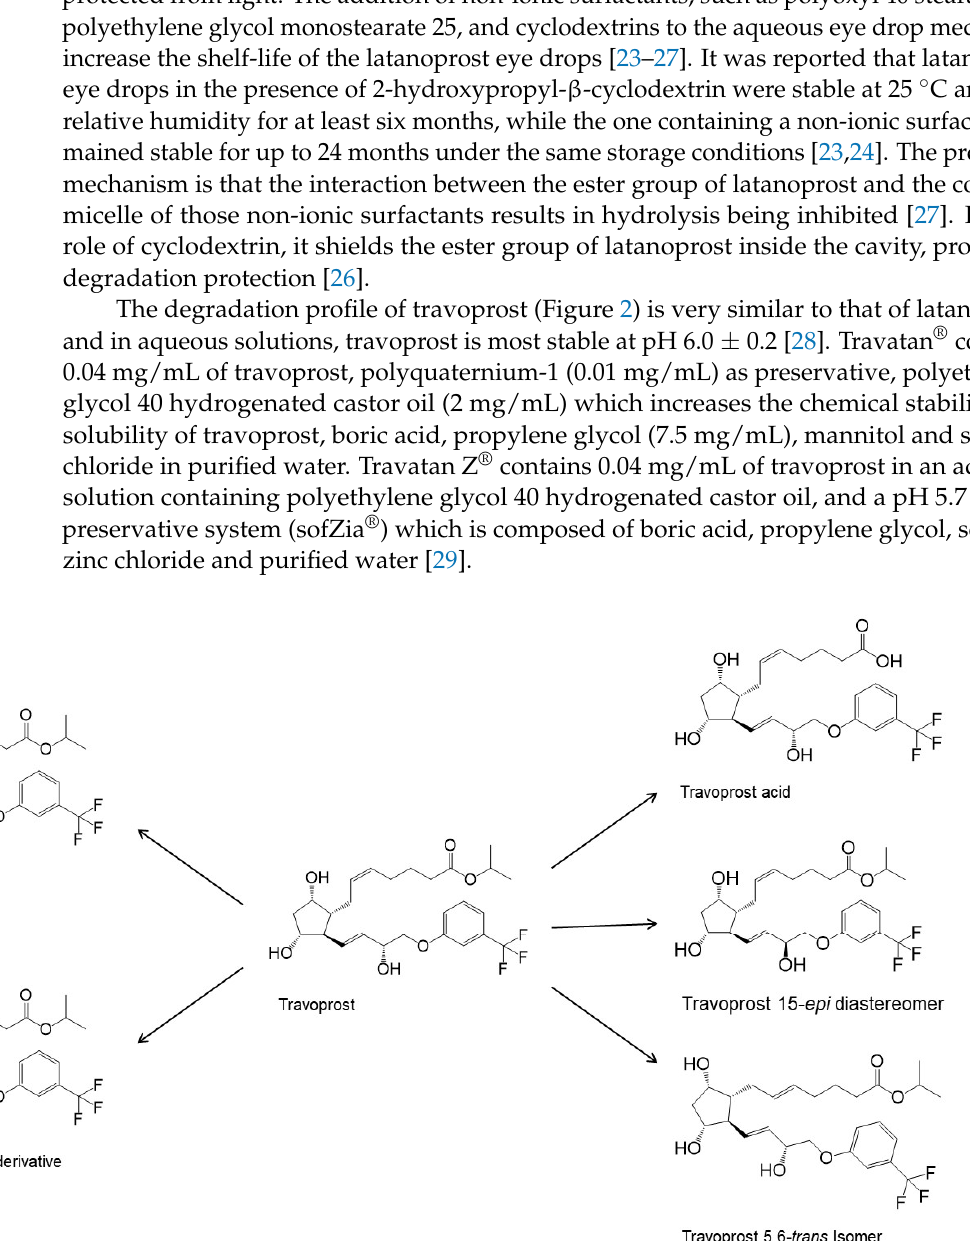
Figure 2. Degradation products of travoprost. Based on USP43-NF38 and reference [30]